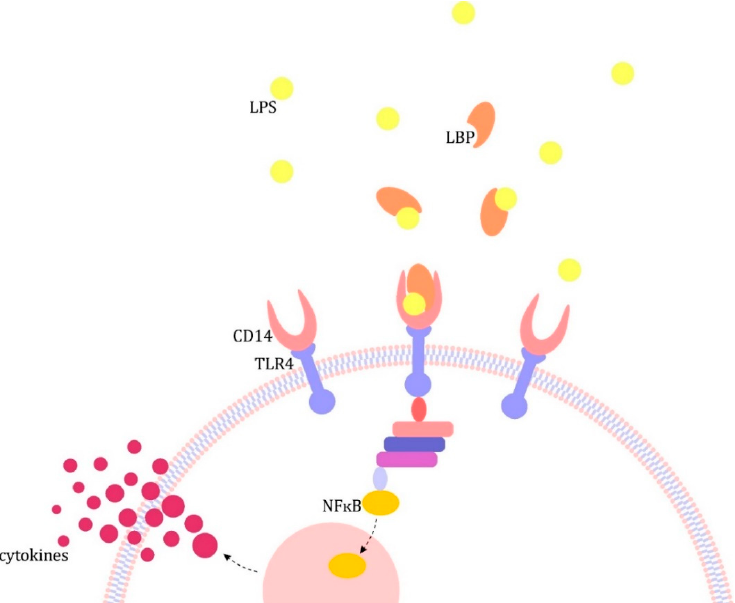
Figure 1. Pathogenesis of sepsis with the example of lipopolysaccharide (LPS). The major patho- mechanism is the formation of complexes in the blood with lipopolysaccharide binding protein (LBP), which in turn binds to CD14 receptors present on monocytes/macrophages and neutrophils and circulating in the plasma. The resulting complex activates Toll-like receptors (TLRs), which transmit the signal inside the cell, leading to the translocation of the nuclear factor kB (NF-kB) to the cell nucleus and activation of pro-inflammatory cytokine gene promoters, including interleukin (IL) 1 and tumor necrosis factor α (TNF- α ) [2].